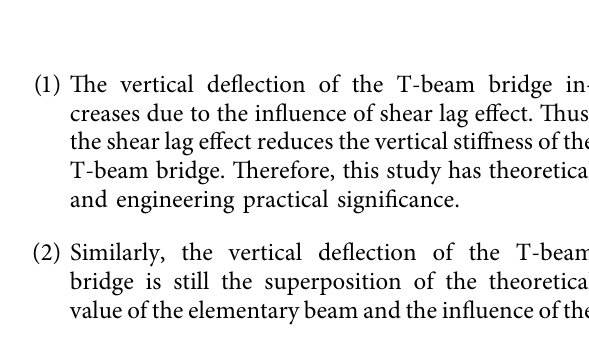
Table 4: Stress on webs for two-span continuous T-beams ( L Vertical coordinates of web